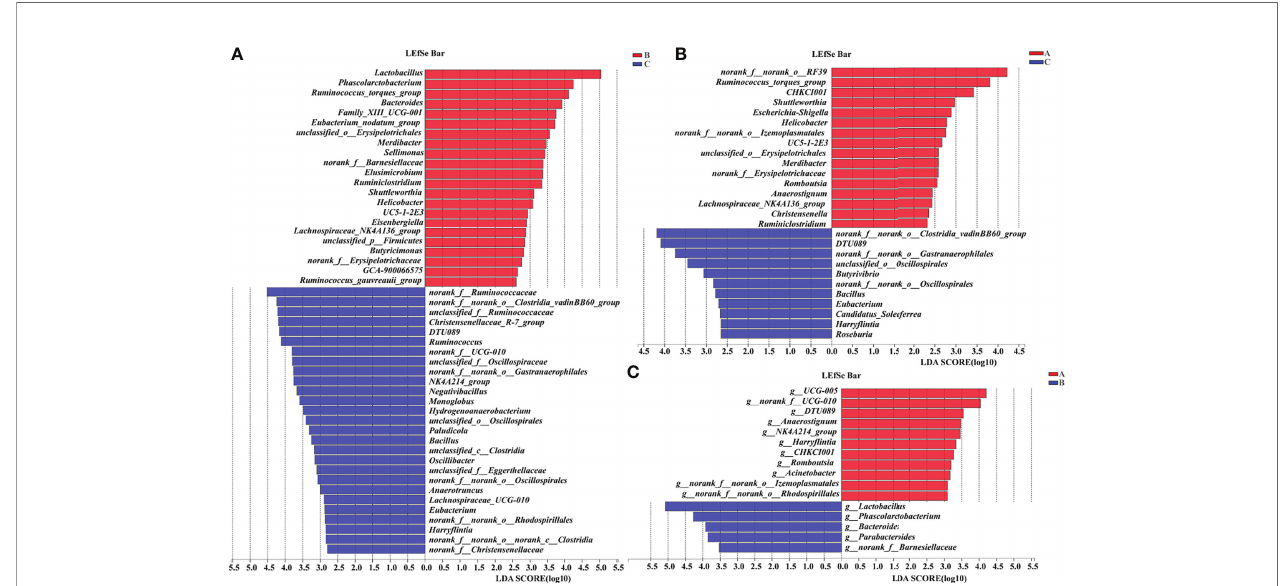
FIGURE 11 | LEfSe analysis of the 16S rRNA sequences of gut microbiota in pullets after 42-day trial (n = 6, LDA > 2). Groups A, B, and C are the control group, the pair-feeding group, and the OTA +AFB1 group, respectively. (A) The LEfSe analysis of the gut microbiota in Group B and Group (C, B) The LEfSe analysis of the gut microbiota in Group A and Group C (C) The LEfSe analysis of the gut microbiota in Group A and Group (B) LEfSe, linear discriminant analysis effect size; LDA, linear discriminant